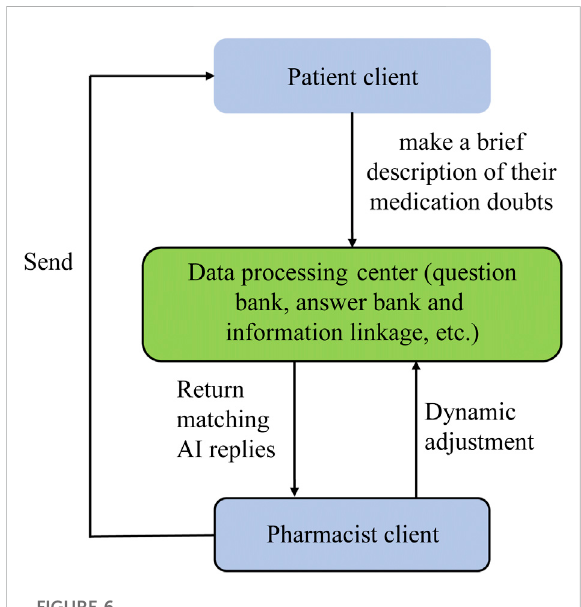
FIGURE 6 Technology roadmap of medication consultation